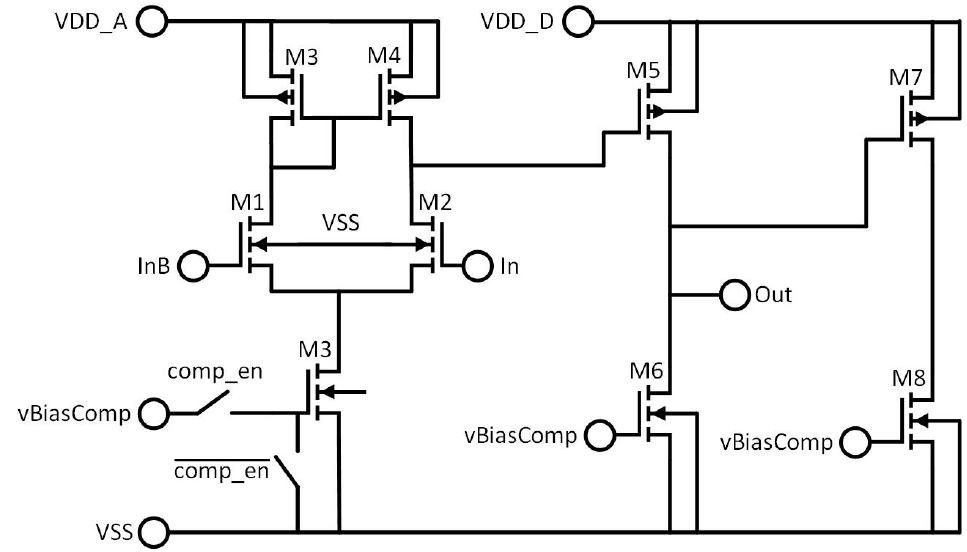
Figure 8. Detailed schematic of the in-pixel